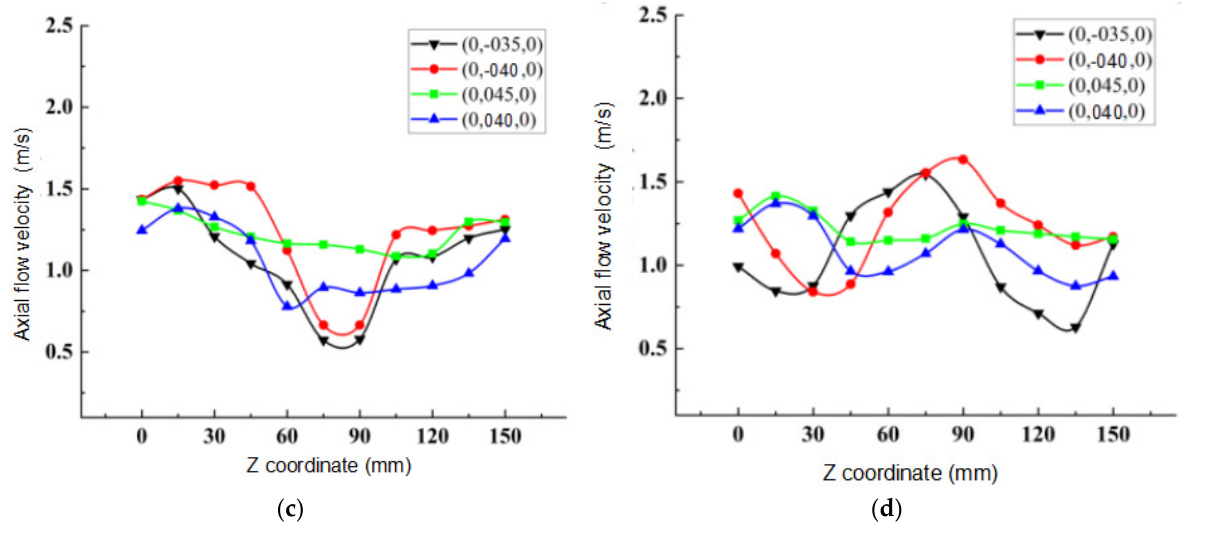
Figure 6. Variation curve of annular slit flow axial velocity at the same measuring point along the flow. ( a ) Position 1; ( b ) position 2; ( c ) position 3; ( d ) position 4.